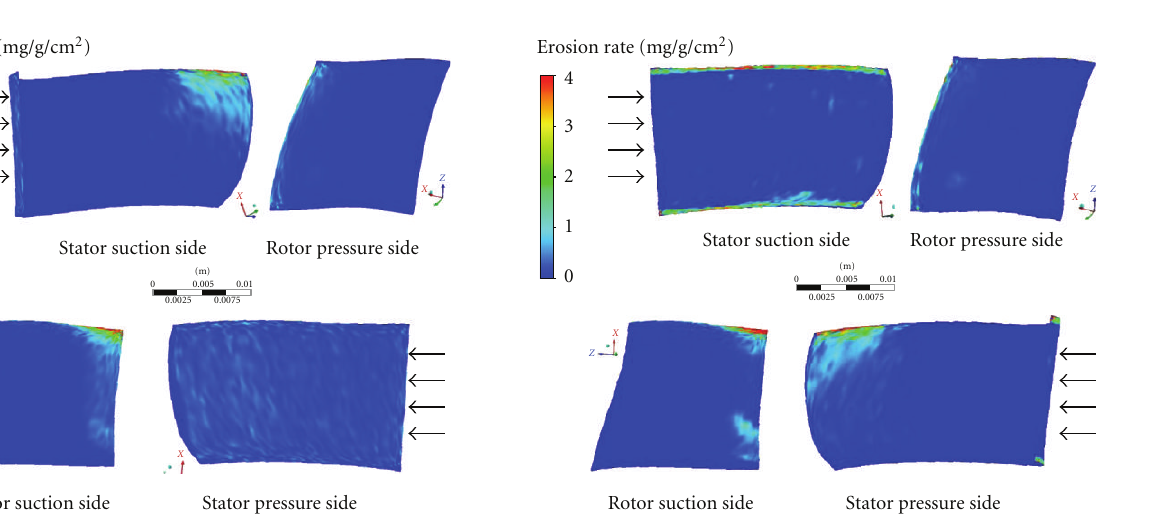
Figure 12: TBC erosion rates on blade surfaces in the commercial turbine for uniform particle loading at 50% of the gas velocity.